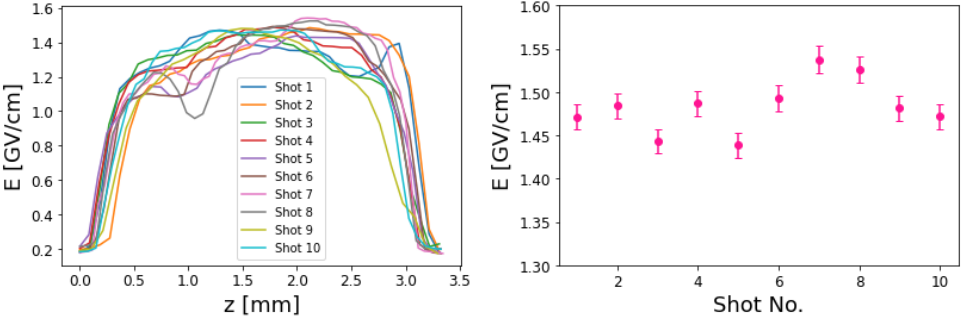
Figure 4. ( Left ): Reconstructed accelerating wakefield axial profiles. ( Right ): shot-to-shot fluctuation of the peak of the longitudinal electric plasma wakefield; the uncertainty is determined by standard deviation of the measurements.